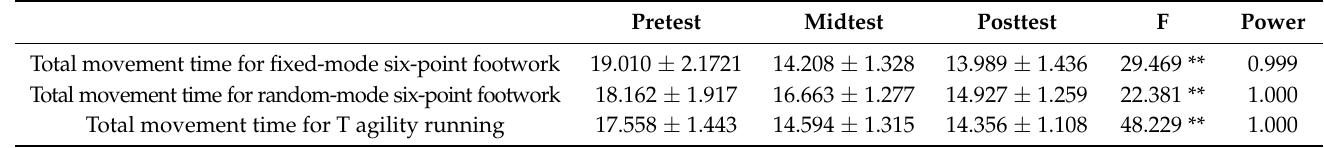
Table 4. Movement time obtained through agility test. Pretest Midtest